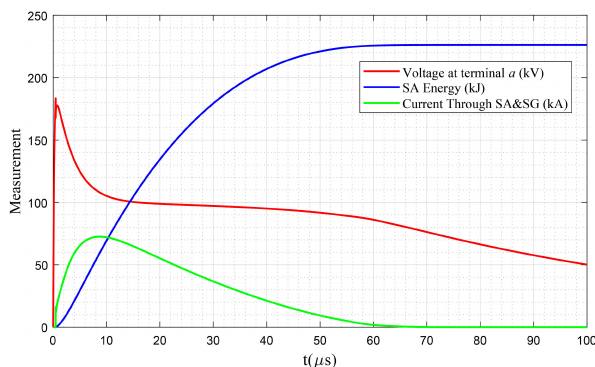
Figure 22. Performance of surge arrester and spark gap connected in series; scenario 3, SA-36b under 175 kV lightning impulse.